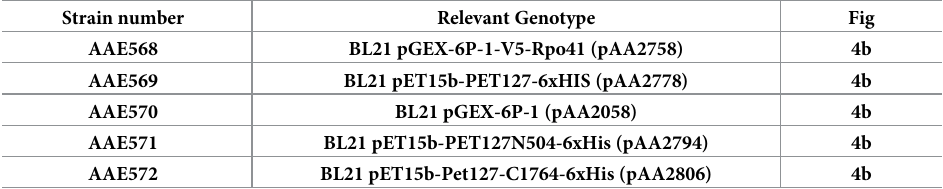
Table 5. List of Bacterial Strains Used in this